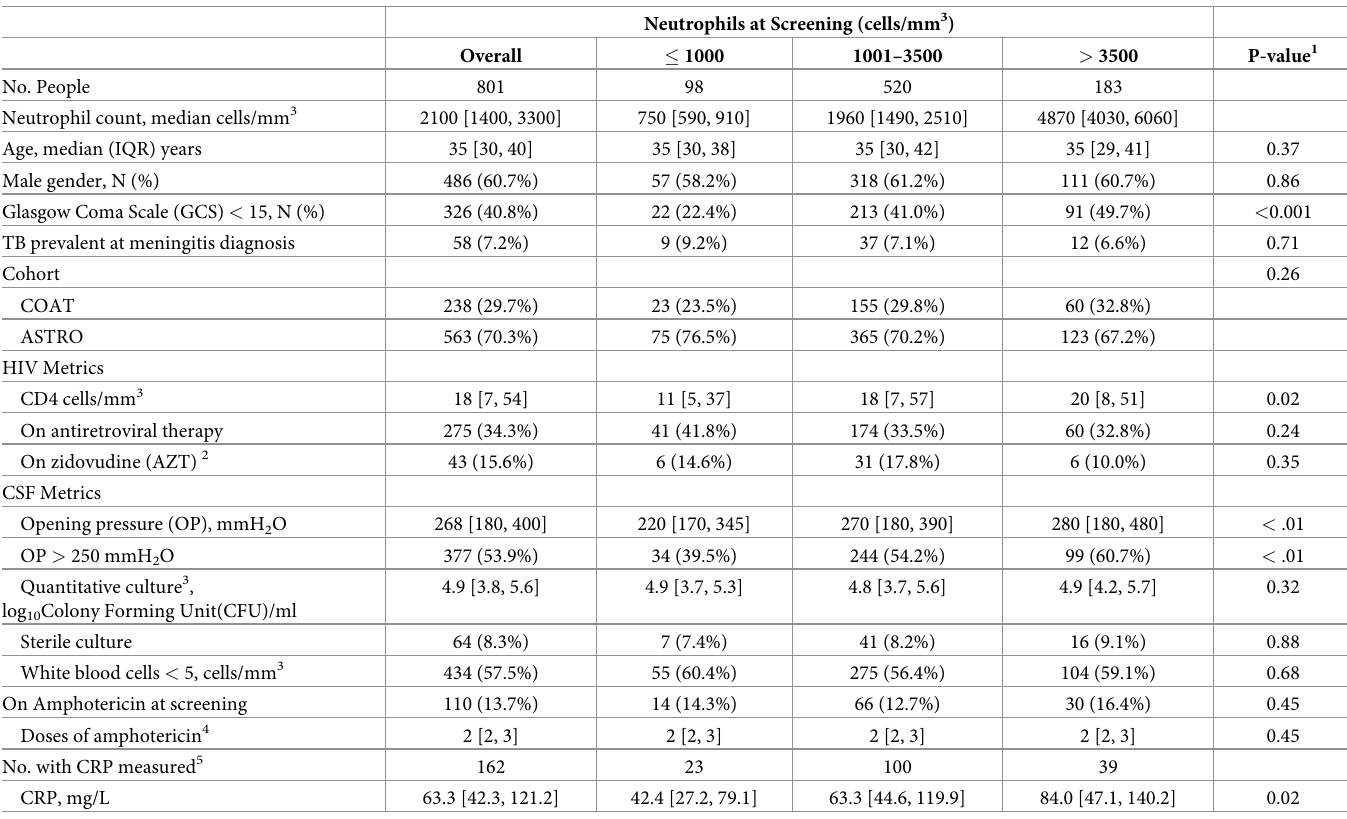
Table 1. Baseline demographics by neutrophil group.